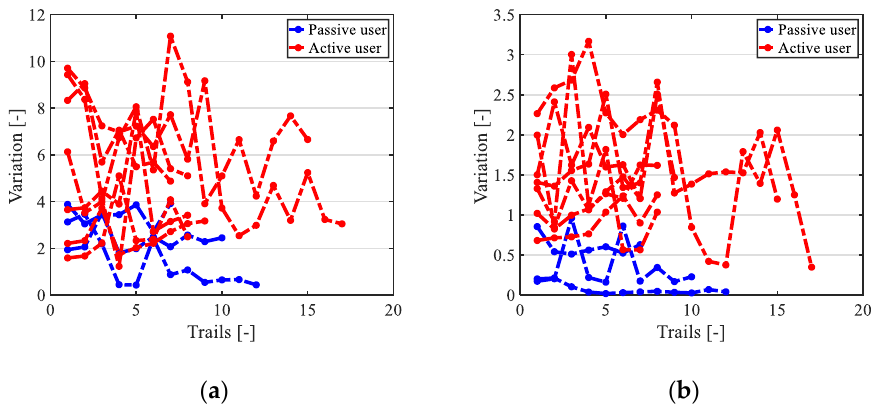
Figure 18. Input changes of active and passive users: ( a ) input changes in v direction and ( b ) input change in 𝜓̇ direction